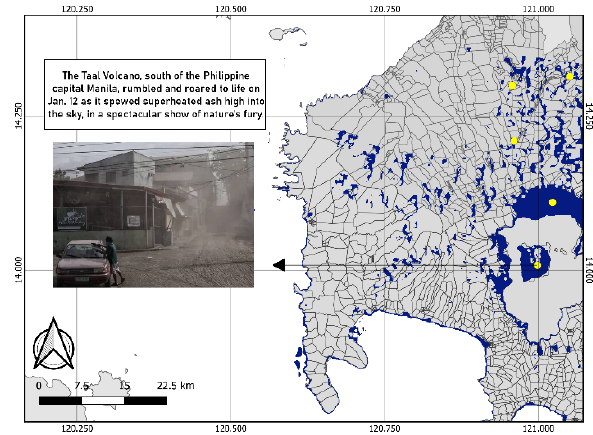
Figure 11. Geocoded tweet (with geotag on the Agoncillo, Batangas) within the classified heavy ash reporting ashfall